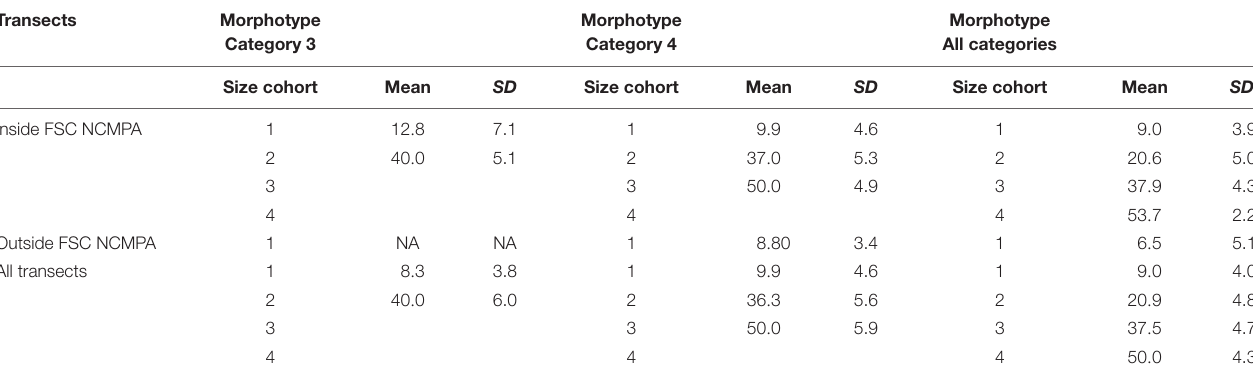
TABLE 4 | Size cohorts (mean ± standard deviation for each cohort) in transects (a) inside the Faroe-Shetland Channel Nature Conservation Marine Protected Area (FSC NCMPA), (b) outside the FSC NCMPA, and (c) across all transects. Transects